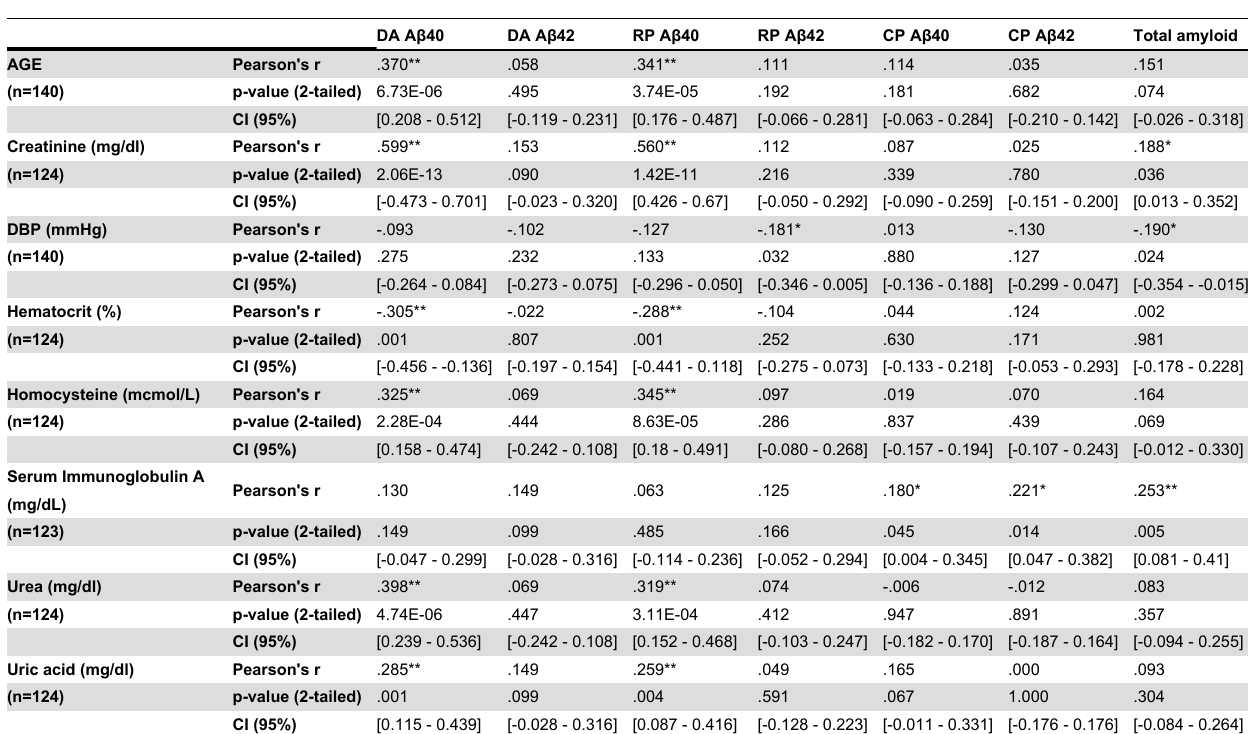
Table 2. Most significant correlations between beta-amyloid measurements and clinical parameters observed in this study.